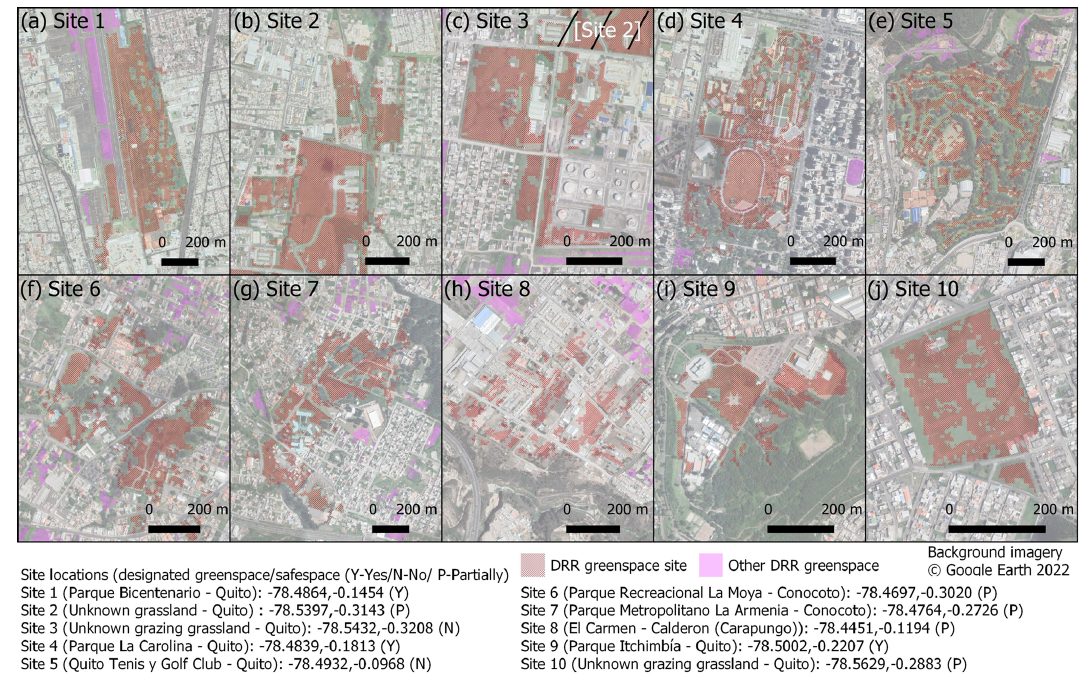
Figure 11. Top 10 ranked DRR greenspaces (red) and other nearby DRR greenspaces (pink) derived using a maximum capacitated coverage network analysis, which finds the greenspaces capable of accommodating the most people within 800m using a minimum space requirement of 3m 2 per person (Sect.